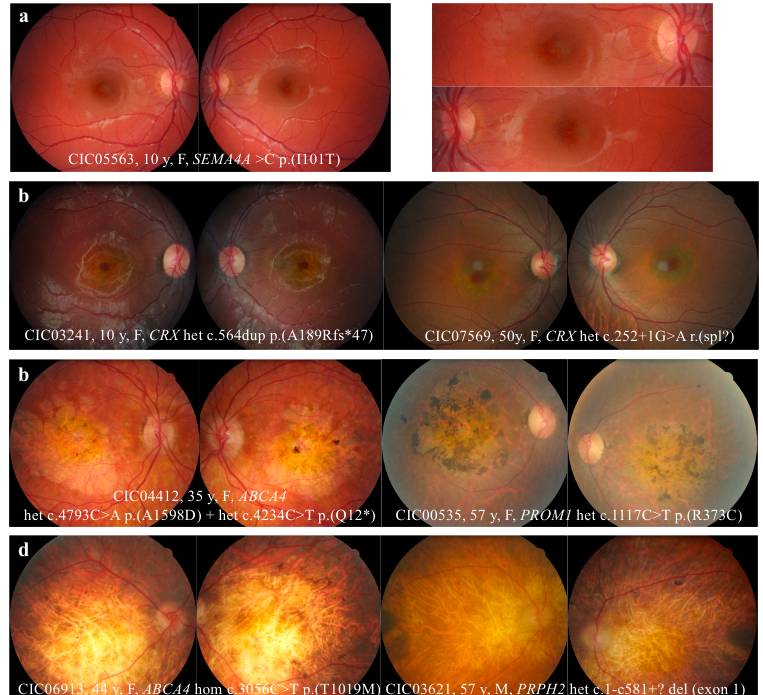
Figure 1. Fundus abnormalities observed in cone and cone-rod dystrophy (COD / CORD) patients of the cohort. ( a ) Macular retinal pigment epithelium (RPE) alterations. ( b ) “Bull’s eye maculopathy” defined by perifoveal atrophy sparing the fovea. Note the temporal pallor of the optic disc for patient CIC03241, a clinical feature known to be associated with CODs. ( c ) Retinal and RPE atrophy limited to the macular region. Note the pigmented aspect above the macular atrophy, sharply marked in patient CIC00535. ( d ) Extensive retinal atrophy from the macula to the peripheral retina. Note the optic disk pallor, narrowing vascular network, and peripheral osteoblasts evoking the di ff erential diagnosis of retinitis pigmentosa.